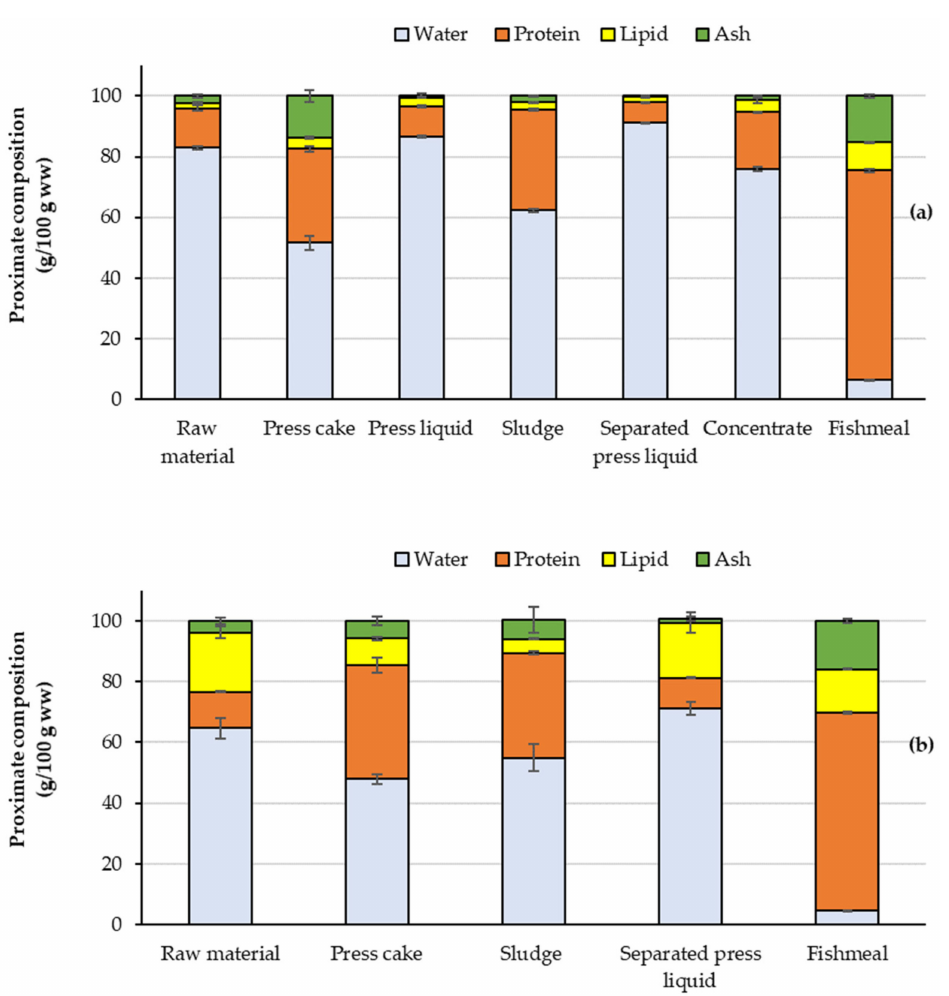
Figure 2. Proximate composition (%, g/100 g ww) in BW ( a ) and the MHB ( b ) fishmeal products during industrial